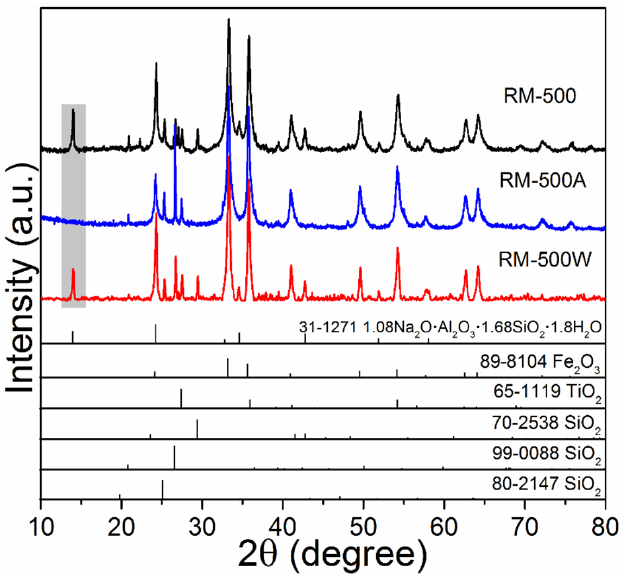
Figure 8. XRD patterns of the RM-500 sample after acid leaching (0.1 M) and water leaching. The dealkalization rate of red mud was evaluated by the chemical composition of samples characterized by XRF. As shown in Figure 9, the weight loss and Na content are the lowest, and the alkali removal rate is the highest in RM-500A. In Table 3, the content of Na is 1.02 wt.% and 2.78 wt.% in RM-500A and RM-800A0.1, respectively. The relevant dealkalization rate was determined according to Equation (7) [38], where X is the dealkalization rate; C 0 and C 1 are the content of Na of the red mud sample before and after acid leaching; and m 0 and m 1 are the weight of the red mud sample before and after acid leaching, respectively. The dealkalization rates are 92.8% and 82.4% for RM-500A and RM-800A0.1, respectively. By the exploration of phase transformation in red mud during the active roasting pretreatment, the more efficient dealkalization of RM-500 than RM-800 benefits from the controlling of the sodium aluminosilicates phase. In addition, the contents of valuable metals, including Fe, Al, and Ti, are increased after diluted acid leaching. The valuable metals can be well preserved in red mud by the advantage of such a low acid concentration, which is mainly ascribed to the high selectivity of acid leaching to alkali in calcined red